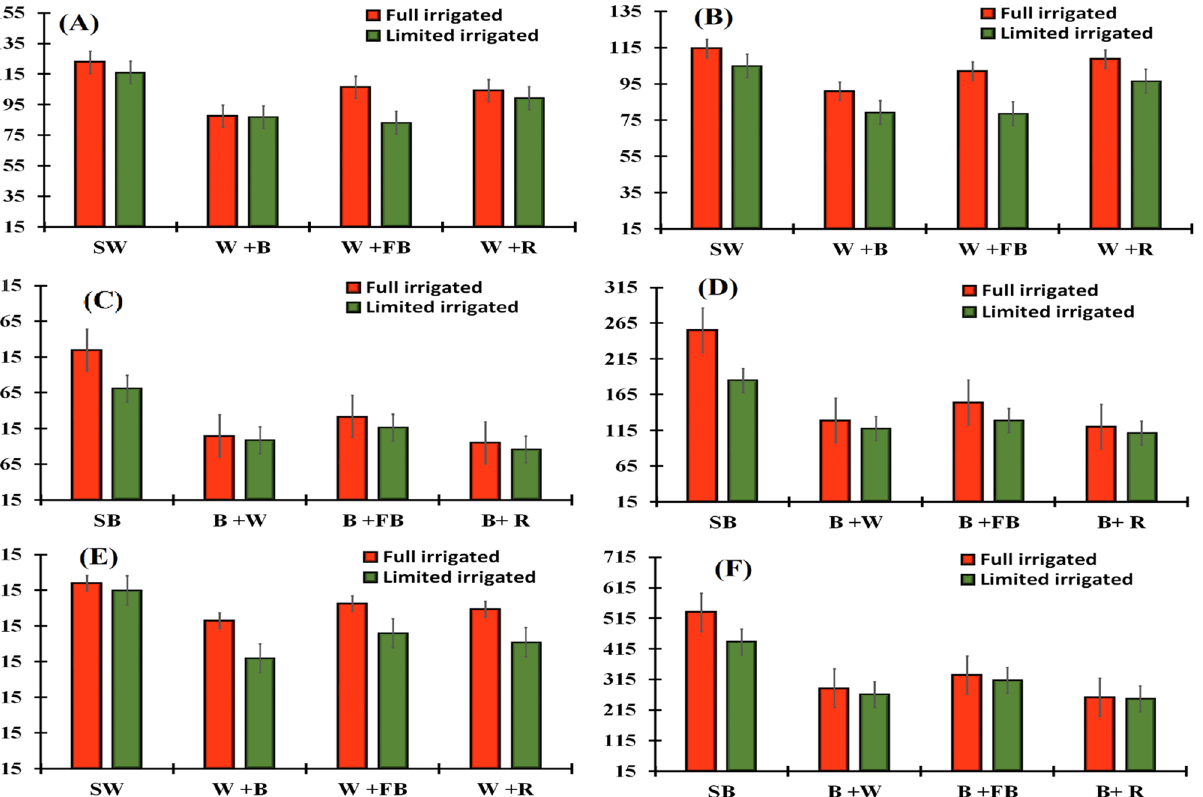
Figure3. Leaves and stem dry weight of barley ( A ) and ( B ), respectively, at anthesis, leaves and stem dry weight of barely ( C , D ), respectively, and spike dry weight of wheat and barley ( E , F ), respectively at physiological